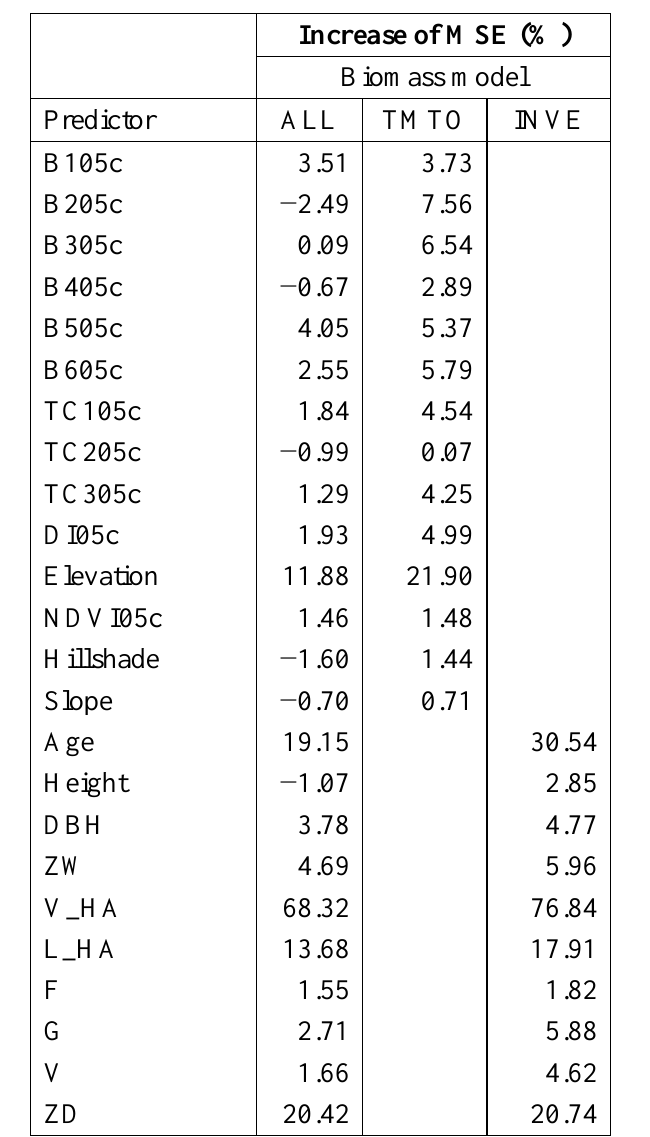
Table 3. Relative importance of predictors.